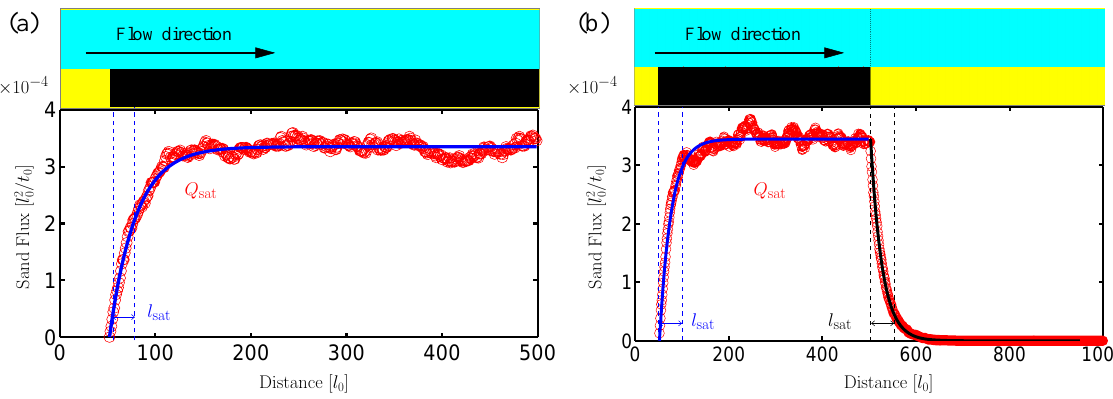
Fig. 4. Saturation length and saturated flux in the simplified cellular automaton model. (a) Downstream of the transition from a non-erodible to an erodible bed, the sediment flux adjusts to the basal shear stress and reaches a stable value Q sat over a characteristic distance l sat . (b) An erodible bed between two non-erodible zones: charge and discharge mechanisms follow the same exponential relaxation regime with the same characteristic length l sat (see blue/black lines and Eq.